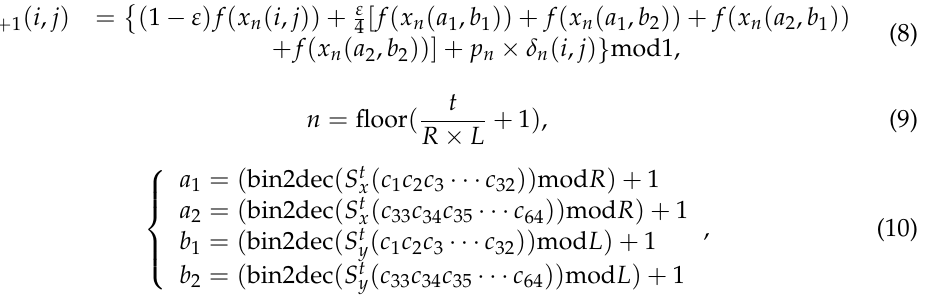
Figure 1. The Partitioned Elementary Cellular Automata.